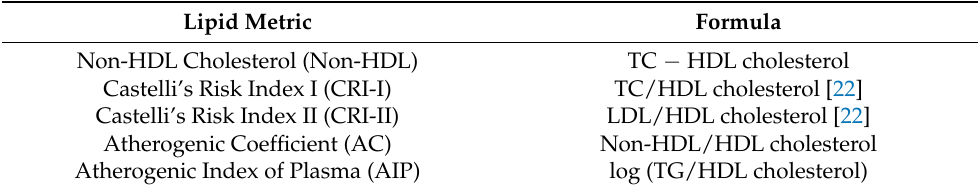
Table 3. Formulae of selected atherogenic indices and lipid